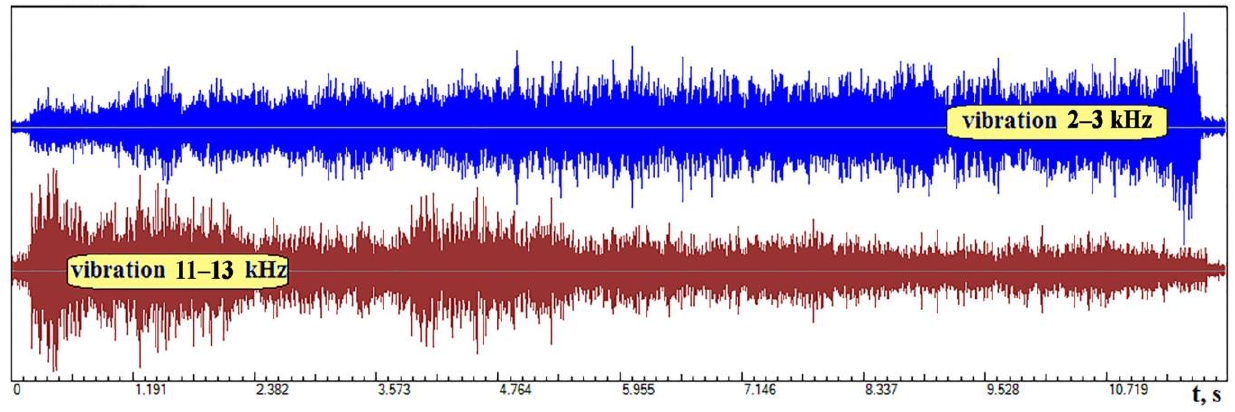
Figure 11. Recording of AE signals in the ranges of 2 – 3 GHz (upper graph) and 11 – 13 kHz (lower graph) during the WEDM of HS123 hard alloy from the moment of embedding to the break of the wire electrode.